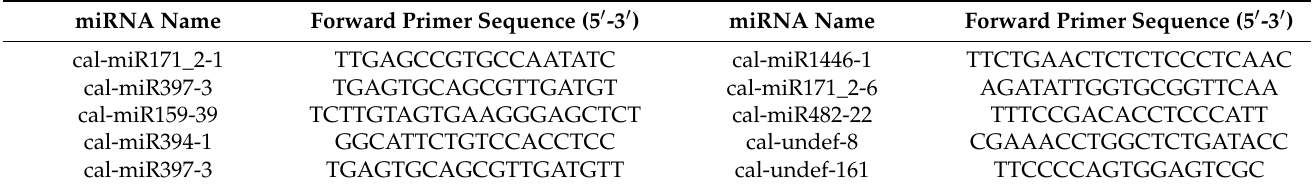
Table 2. The miRNA primers used in this study. The universal miRNA qRT-PCR primer (5 (cid:48)